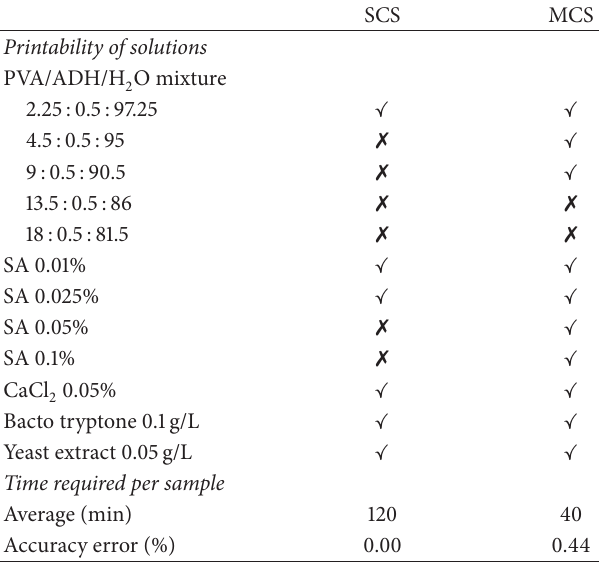
Figure 11: CA hydrogel on hydrophilic areas on hydrophilic/hydro- phobic patterned paper. Table 1: Printability and time required per sample of SCS and MCS printers with sodium alginate (SA) solutions.